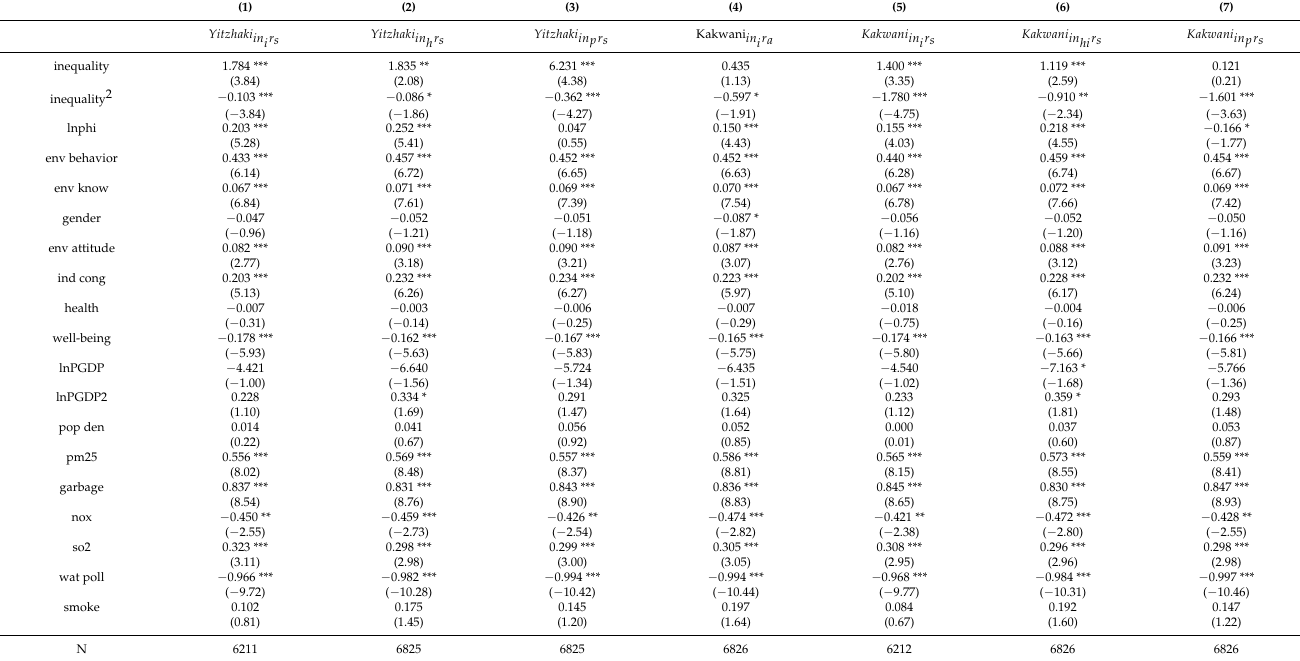
Table A7. The effect of individual-level income inequality on subjective environmental pollution: robustness test based on different measurements of income inequality at the individual level.